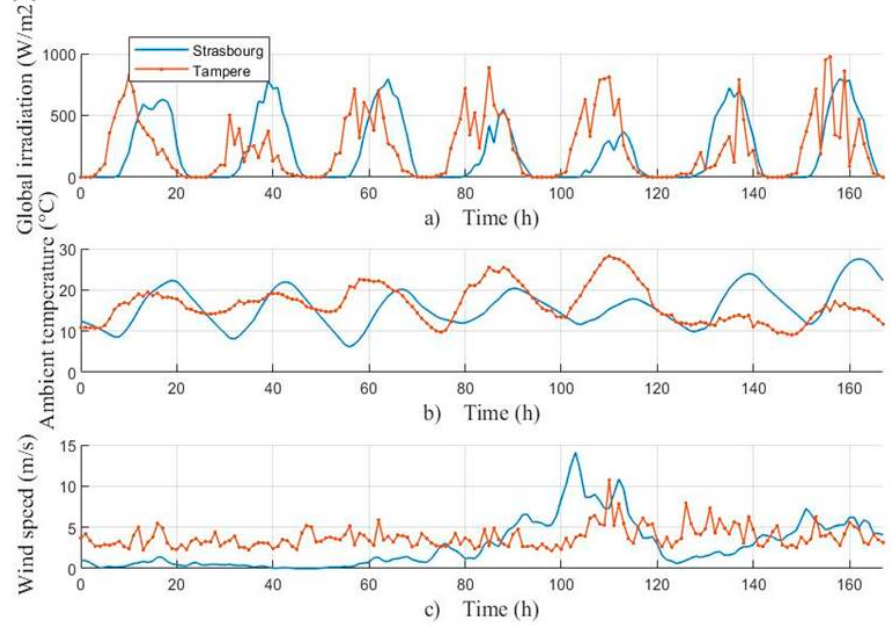
Figure 2. Climate conditions during the summer week in Tampere and Strasbourg: ( a ) solar irradiation; ( b ) ambient temperature; ( c ) wind speed.